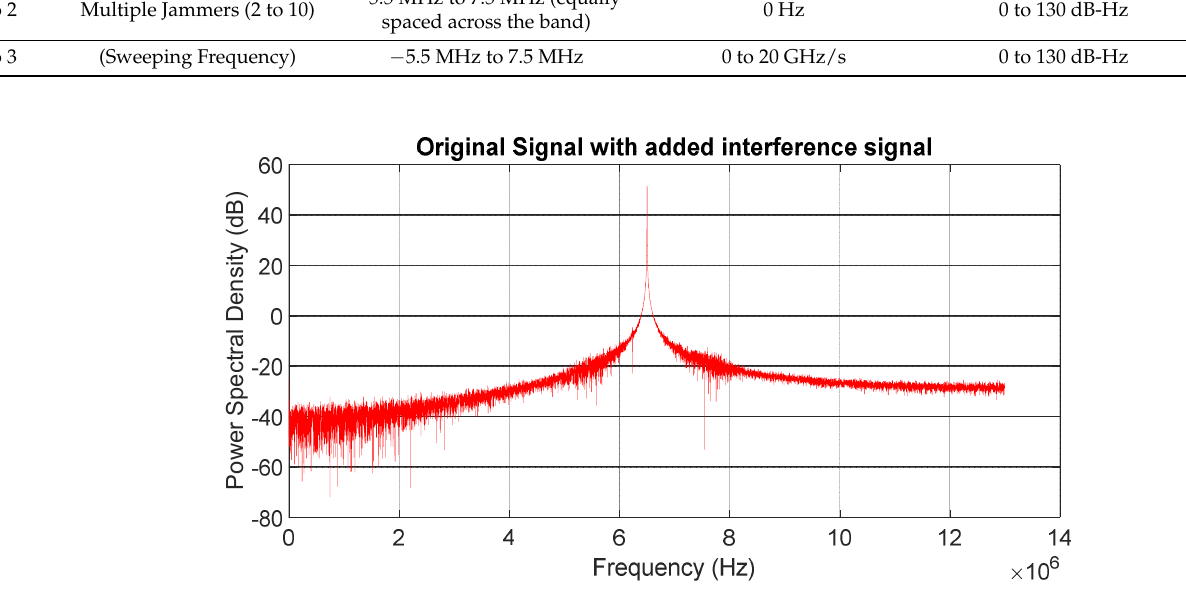
Figure 4. Example of a continuous-wave jammer with (J/No) = 80 dB-Hz .